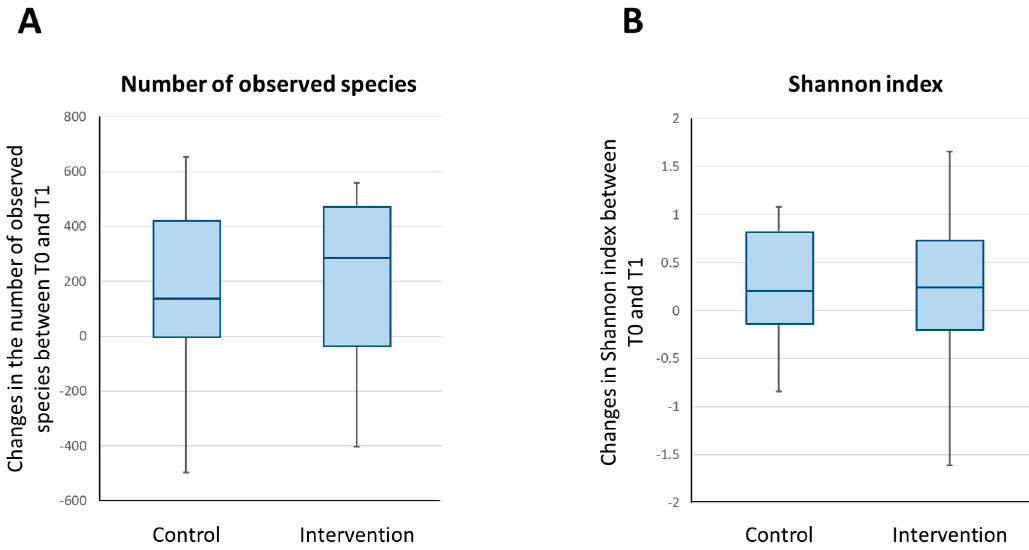
Figure 3. Changes in the alpha diversity parameters of the intestinal microbiota of the participants between baseline and post-intervention. The box and whisker plots show the median, lower quartile, upper quartile, minimum value and maximum value of the number of observed species in the intestinal microbiota of the participants ( A ) and the Shannon index ( B ).